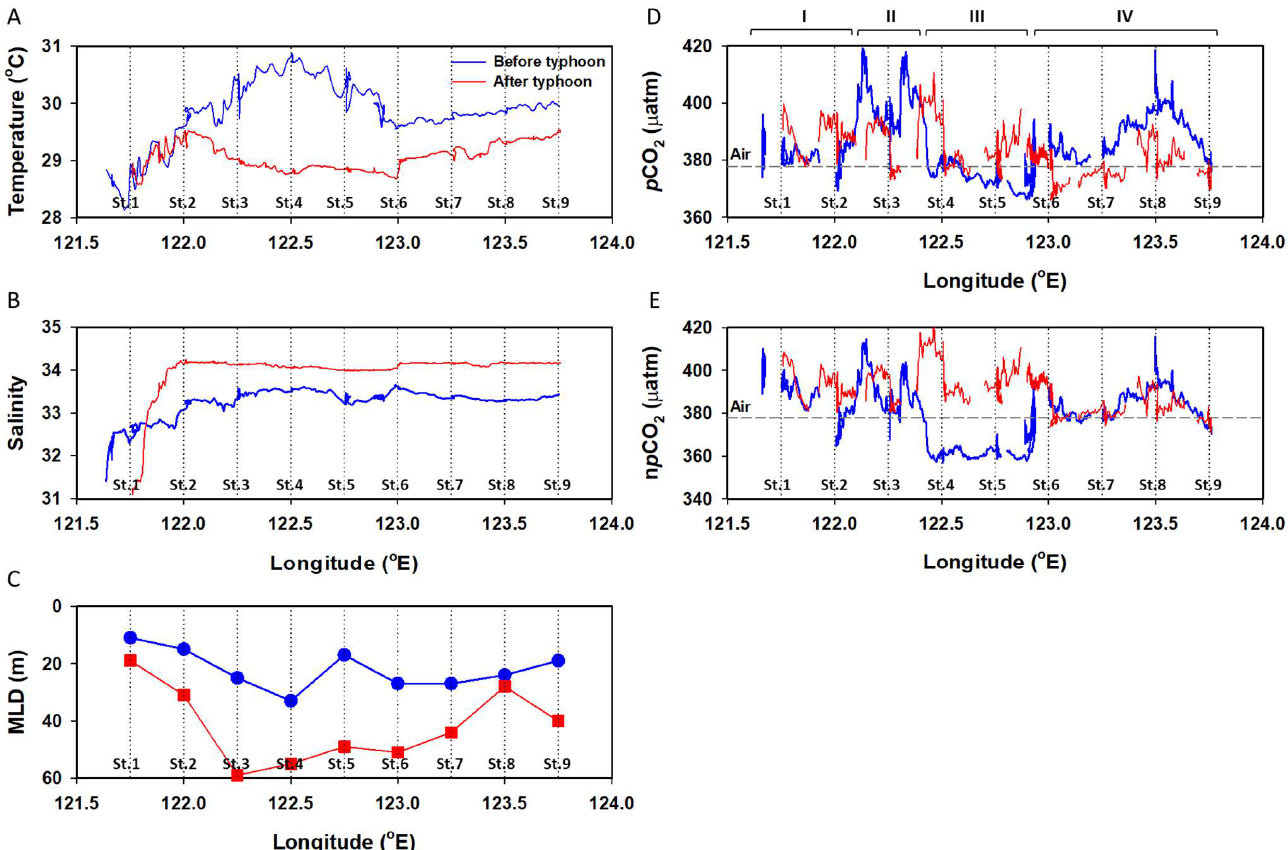
Figure 2. Underway measurements of ( A ) surface temperature, ( B ) salinity, ( C ) mixed-layer depth (MLD), ( D ) p CO 2 , and ( E ) temperature normalized p CO 2 (n p CO 2 ) during the pre-typhoon (blue line) and the post-typhoon (red line) cruises. Gray dash line in ( D , E ) refers to the monthly average atmosphere p CO 2 during the study period.